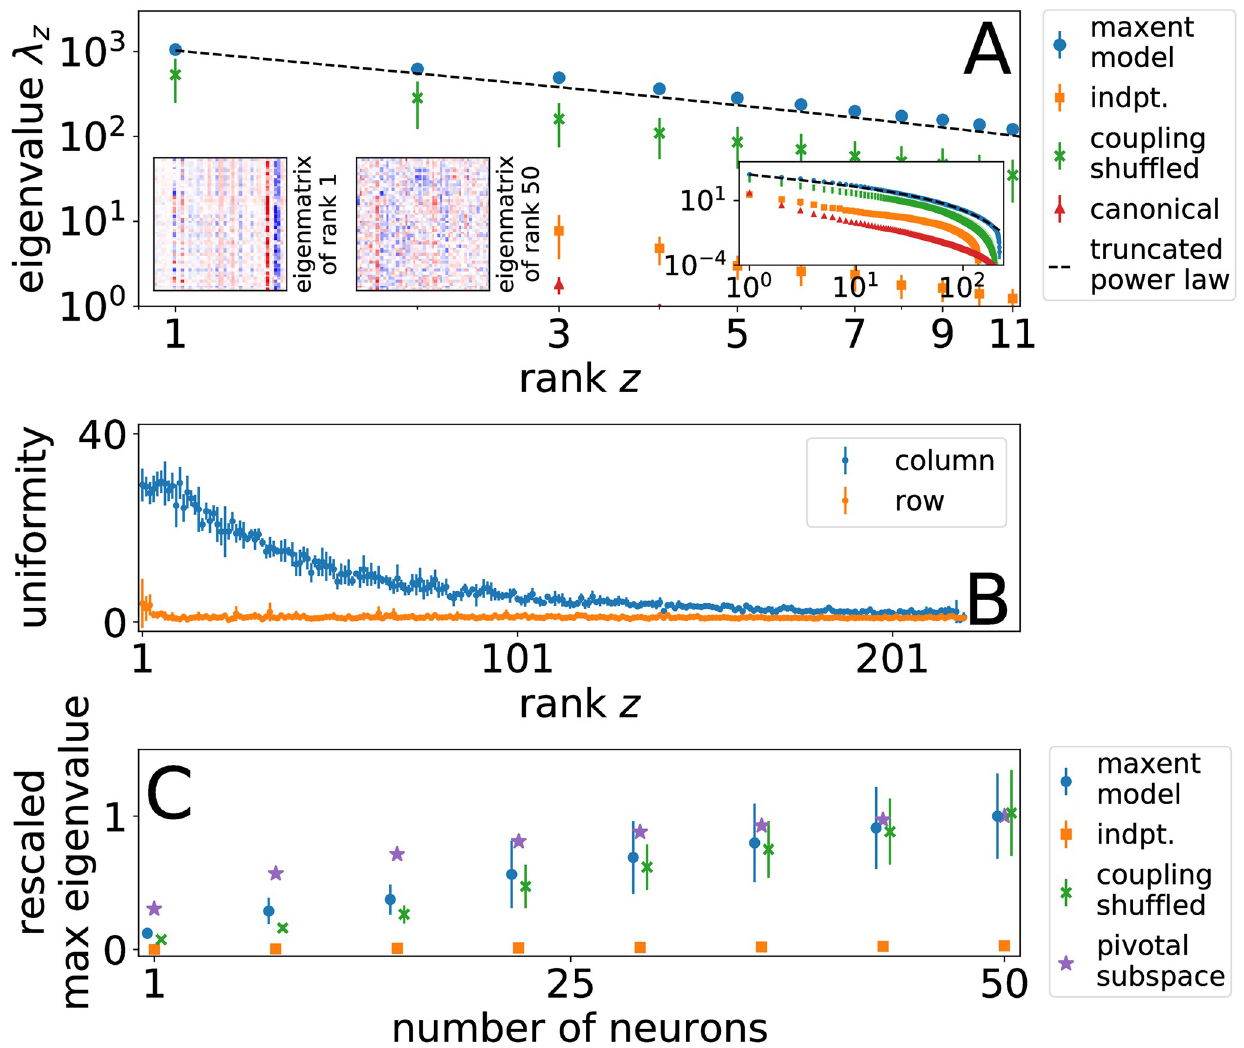
Fig 4. (A) FIM eigenvalue spectrum for pairwise maxent, independent (indpt.) and shuffled couplings null models. Results are averaged over M Monte Carlo samples ( M = 10 for maxent model and random shuffles, M = 4 for indpt. and canonical). For comparison, we show response to canonical perturbation to couplings. Insets on left show example eigenmatrices of rank 1 and 50, but only the first displays strong vertical striations. Inset on right shows full eigenvalue spectrum. Error bars show standard error of the mean. (B) Eigenmatrix column and row uniformity. Error bars represent a standard deviation across Monte Carlo samples. (C) Rescaled sensitivity. Principal FIM eigenvalues but for neuron subsamples as a function of subsample size. Normalized by the average maximum eigenvalue for the maxent model. Error bars represent standard deviation around means of Monte Carlo samples. Points have been offset for visibility along the x-axis. Compare with Fig P in S1